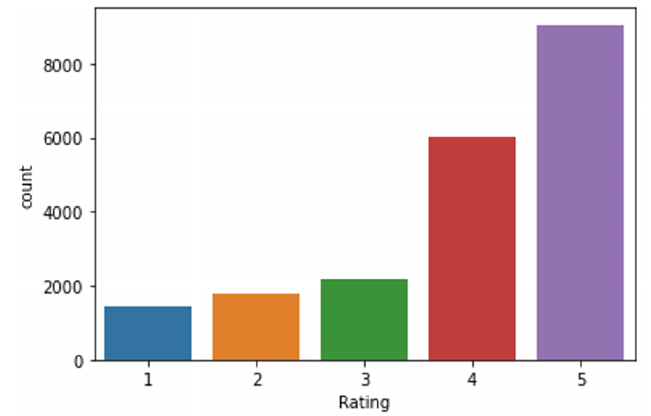
Figure 1. Distribution by “Rating”.